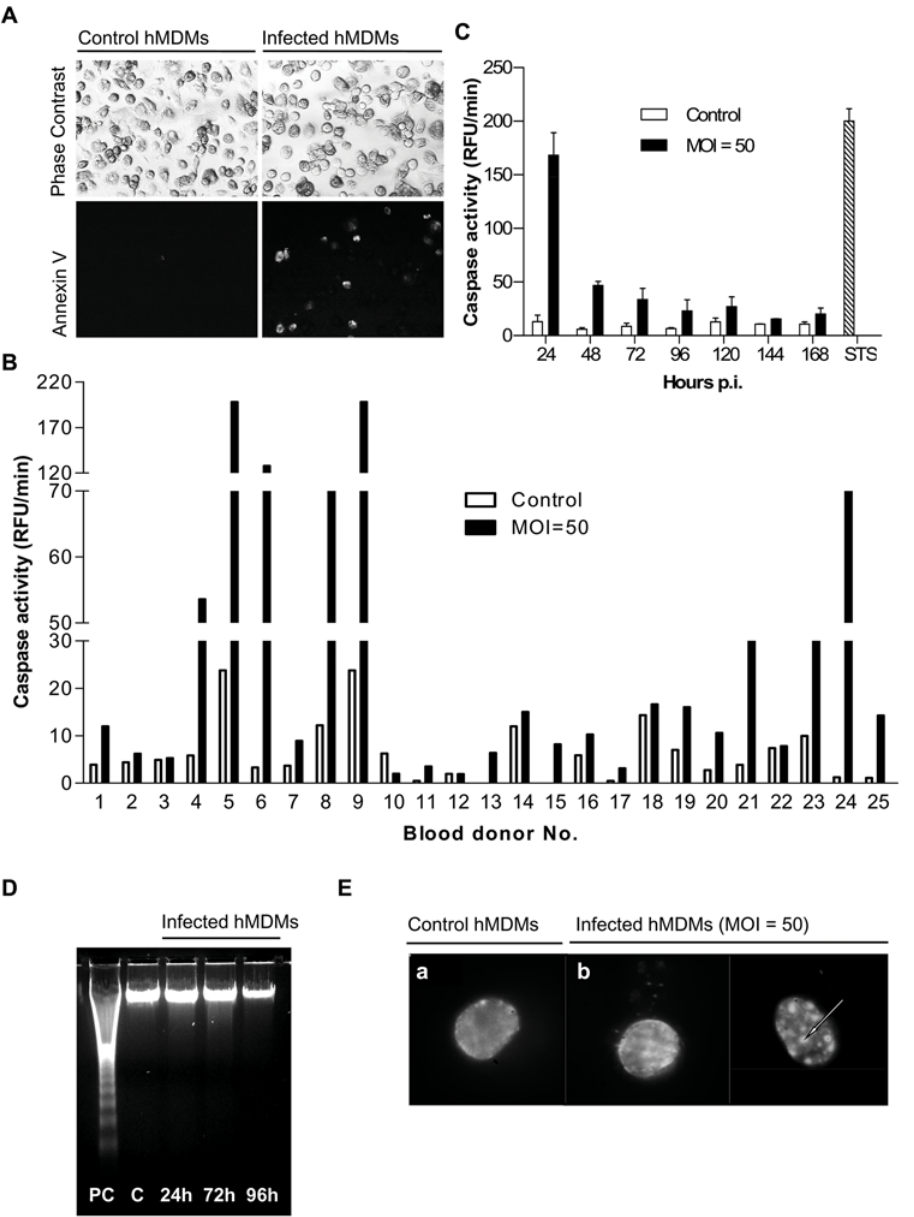
Figure 1. S.aureus infection of hMDMs causes transient caspase-3 activation in a donor-dependent manner without development of late apoptotic features. hMDMs were allowed to phagocytose S. aureus at a ratio of 50 bacteria per macrophage (MOI 1:50) for 2 h. Bacteria were then removed and cells were cultured for an additional 6–168 h. At the indicated time points the infected cells were analyzed for apoptotic changes. ( A ) Phosphatidylserine (PS) externalization to the cell surface was examined under a fluorescence microscope after staining cells with FITC-annexin V. Upper and lower panels show transmission and fluorescent light micrographs ( 6 20), respectively, of control, mock-infected macrophages (left panel) and S. aureus -infected cells (right panel) maintained in culture for 6 h. The presented photographs are representative of a minimum of 20 fields observed during 3 independent experiments. ( B ) The activity of caspase-3 (RFU/min) in infected and control cultures of hMDMs originating from 25 blood donors was measured with DEVD-AFC 24 h after S. aureus phagocytosis. ( C ) Infected macrophage cultures were maintained for 168 h post- phagocytosis and caspase-3 activity (RFU/min) was determined at 24 h intervals. The figure is representative of several experiments, each performed in triplicate, using hMDMs cultures responding to S. aureus infection with strong procaspase-3 activation. Macrophages treated with STS for 24 h were used as a positive control. STS, staurosporine. ( D ) Lack of DNA fragmentation examined by agarose electrophoresis at 24, 48 and 72 h after S. aureus phagocytosis (representative result). ( E ) Assessment of chromatin condensation in infected hMDMs (24 h post-phagocytosis) using DAPI staining fluorescence microscopy (100 6 ). Only occasional, slight chromatin condensation was visible (arrowheads). The results presented are from one representative experiment out of 5. Scale bars=10 m